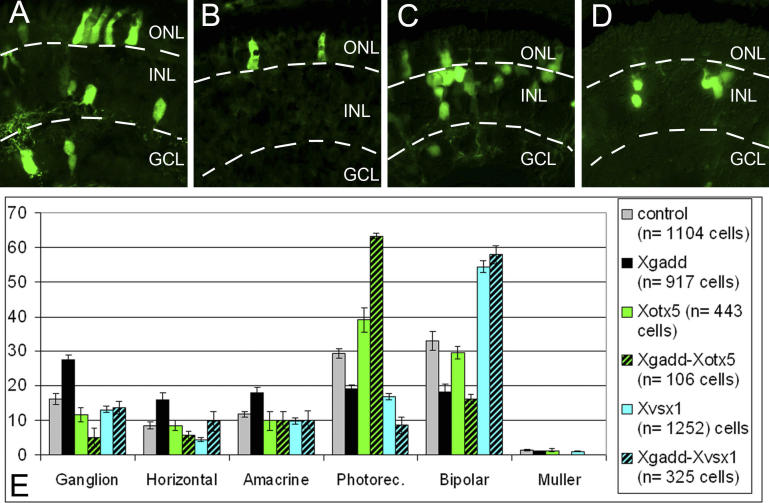

Xotx5b and Xvsx1 Counteract the Inhibitory Effects of Xgadd-45γ on the Differentiation of Photoreceptors and Bipolar Cells(A–D) Examples of retinal sections from embryos lipofected with Xotx5b (A), Xotx5b and Xgadd-45γ (B), Xvsx1 (C), and Xvsx1 and Xgadd-45γ (D). ONL, outer nuclear layer; INL, inner nuclear layer; GCL, ganglion cell layer.(E) Statistical analysis showing the proportion of lipofected cell types after lipofection of the constructs indicated in legend. Number of lipofected cells is indicated by n. Error bars indicate standard error of the mean.